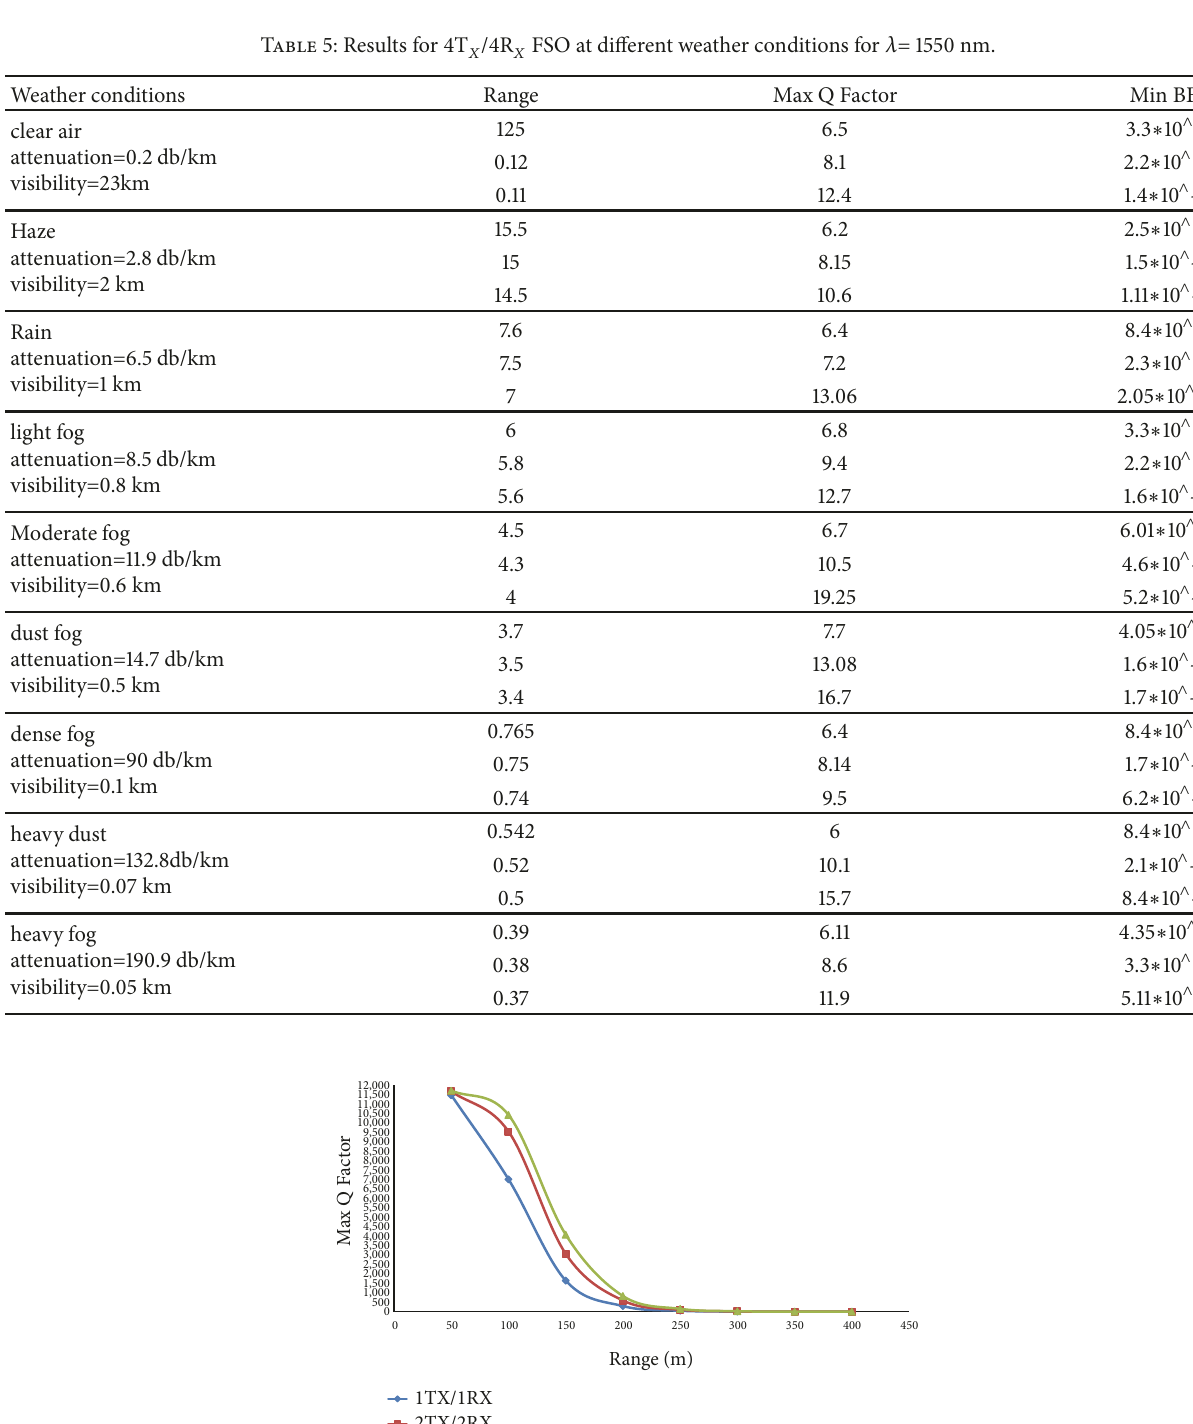
Increasing laser power to 25 dbm at wavelength=1550 nm using 1T X /1R X , the max distance obtained=370 m, while using 2T X /2R X the max distance obtained=400 m, and while using 4T X /4R X the max distance obtained=414m as shown in Figure